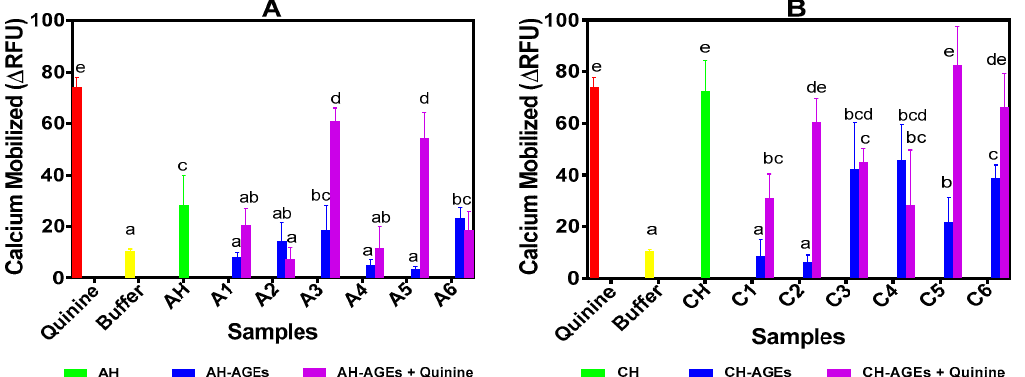
Figure 2. Calcium mobilization in T2R4 expressing HEK293T cell system after treatment with protein hydrolysates, glycated protein hydrolysates (5 mg/mL) and quinine (1 mM): A. alcalase hydrolysate (AH), 1% AH + 0.3 M D-glucose (A1), 3% AH + 0.3 M D-glucose (A2), 1% AH + 0.4 M D-glucose (A3), 3% AH + 0.4 M D-glucose (A4), 1% AH + 0.5 M D-glucose (A5), 3% AH + 0.5 M D-glucose (A6); B. chymotrypsin hydrolysate (CH), 1% CH + 0.1 M D-glucose (C1), 3% CH + 0.1 M D-glucose (C2), 3% CH + 0.2 M D-glucose (C3), 3% CH + 0.3 M D-glucose (C4), 3% CH + 0.4 M D-glucose (C5), 3% CH + 0.5 M D-glucose (C6). Bars with different letters have significantly different ( p < 0.05) mean values as determined from Duncan Multiple Range tests while error bars represent standard deviation. Δ RFU: changes in relative fluorescence unit (test cells minus control cells).